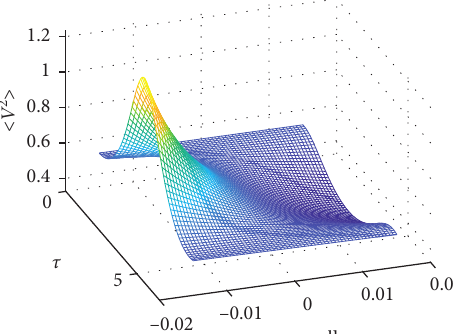
Figure 5: The influences of time delay and feedback strength on the MSEV.